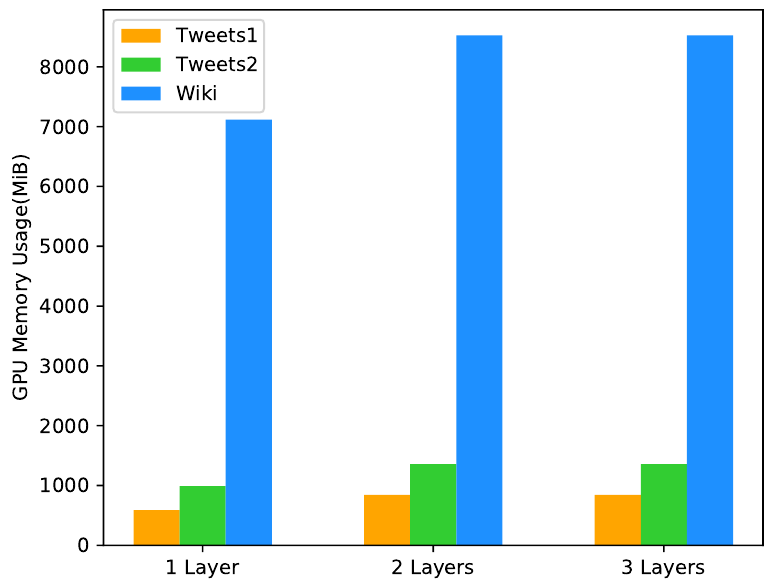
Figure 7. Average GPU Usage with Various Number of Bi-GRU Layers.